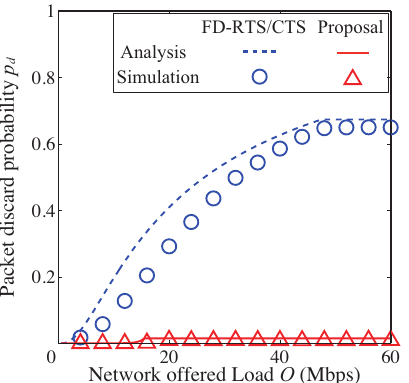
Figure 8. Packet discard probability as a function of offered load for N =